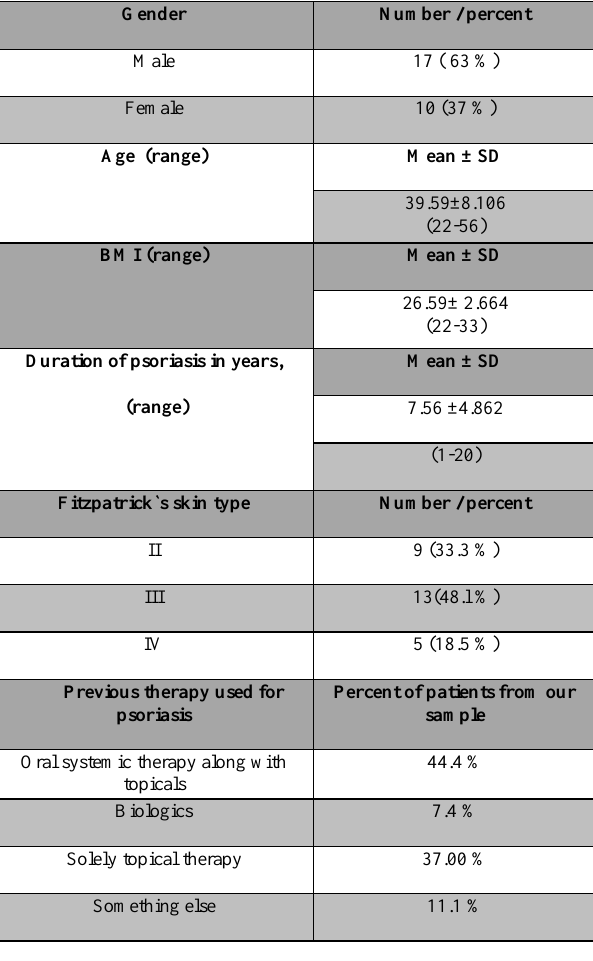
Table 1. Characteristics of the patients included in the study.